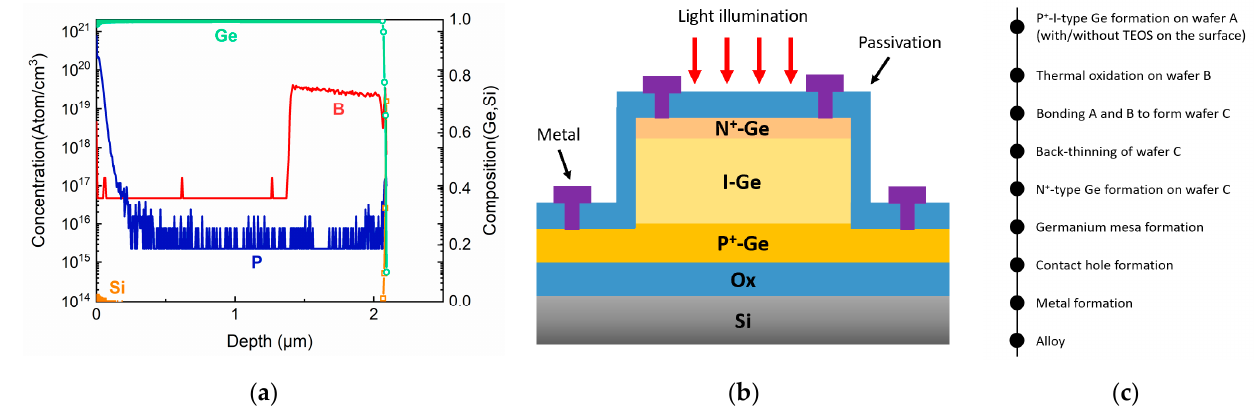
Figure 1. ( a ) SIMS data, ( b ) cross-section schematic, and ( c ) main process flow of GOI p-i-n